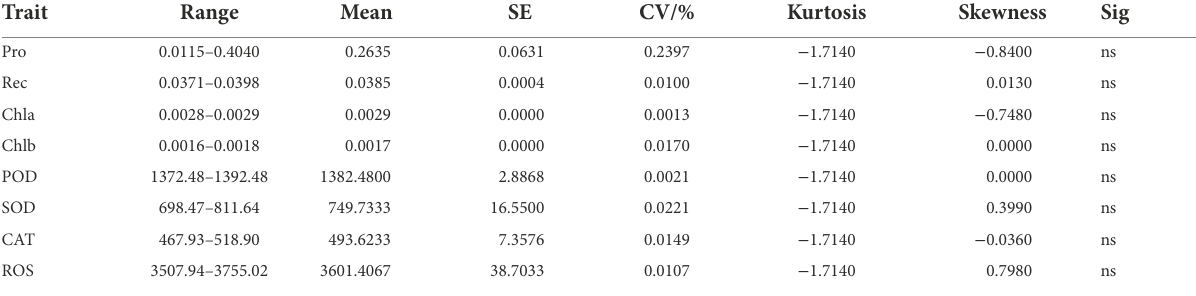
TABLE 1 Statistical description of Helictotrichon virescens phenotypic data at 25 °